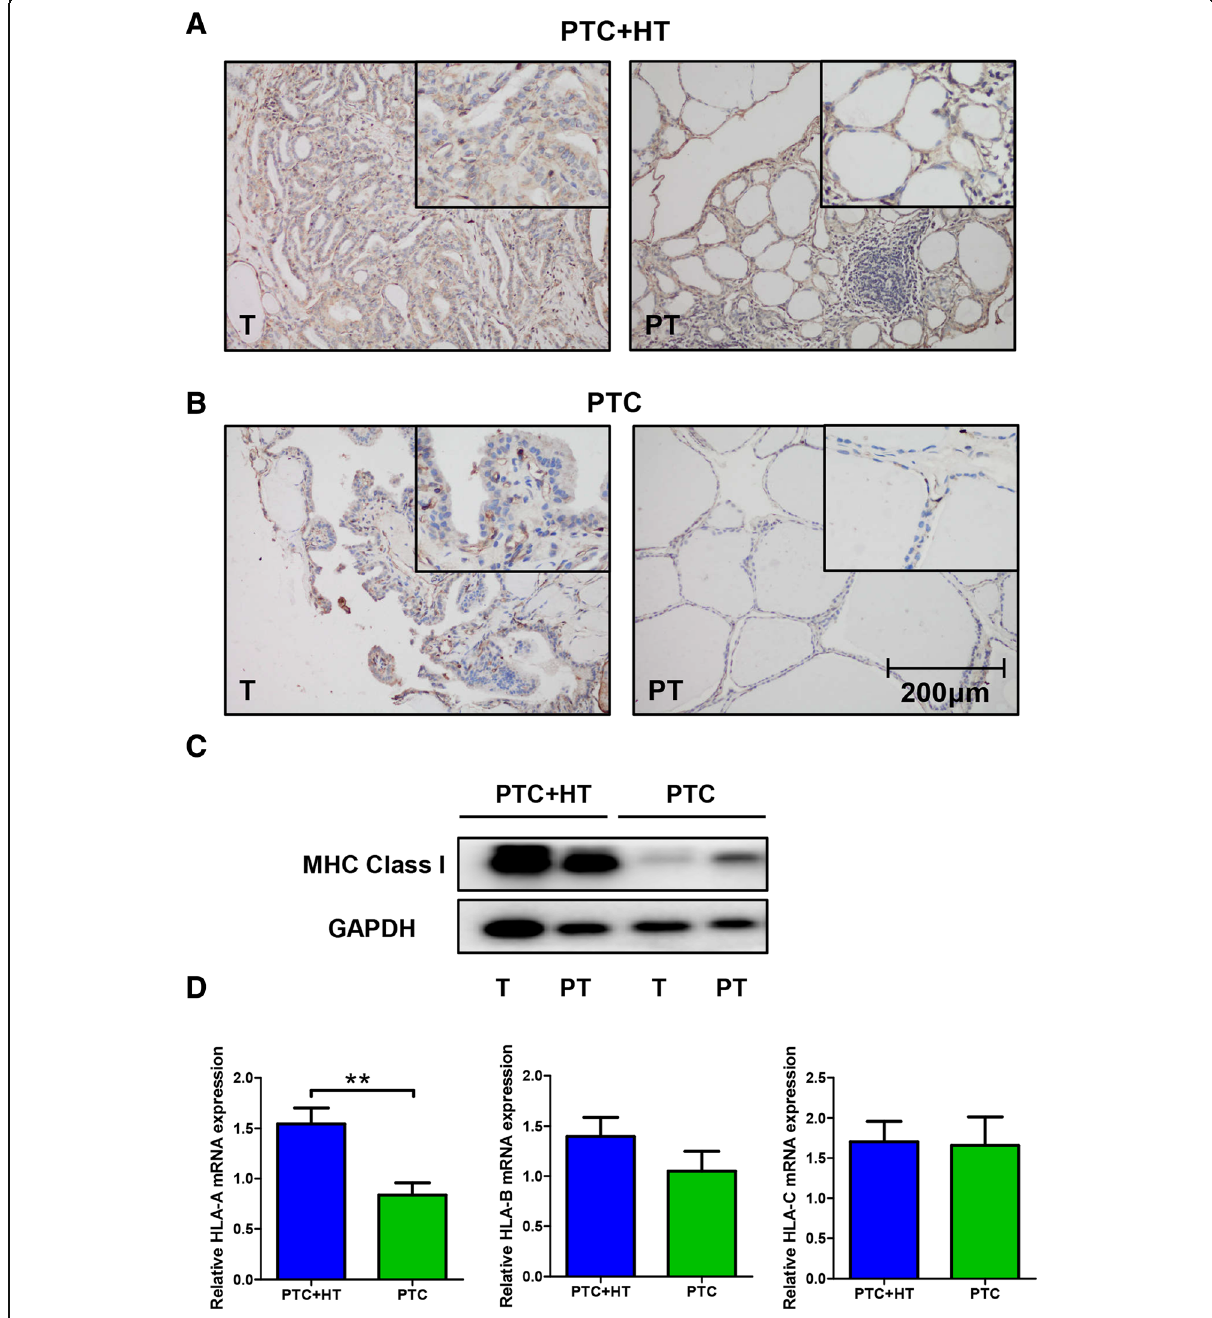
Fig. 2 Elevated MHC Class I expression in PTC + HT. a - b , representative IHC pictures of MHC Class I molecules in PTC + HT tumor and adjacent para-tumor tissue ( a ), PTC tumor and adjacent para-tumor tissue ( b ). (original magnification, 200×; the right upper quadrant, 400×) c , MHC Class I expression in tissue samples of PTC with/without HT measured by Western blotting. d , qPCR analysis of relative HLA-A, HLA-B and HLA-C expression between tumor tissues from PTC patients with/without HT. ( ** P